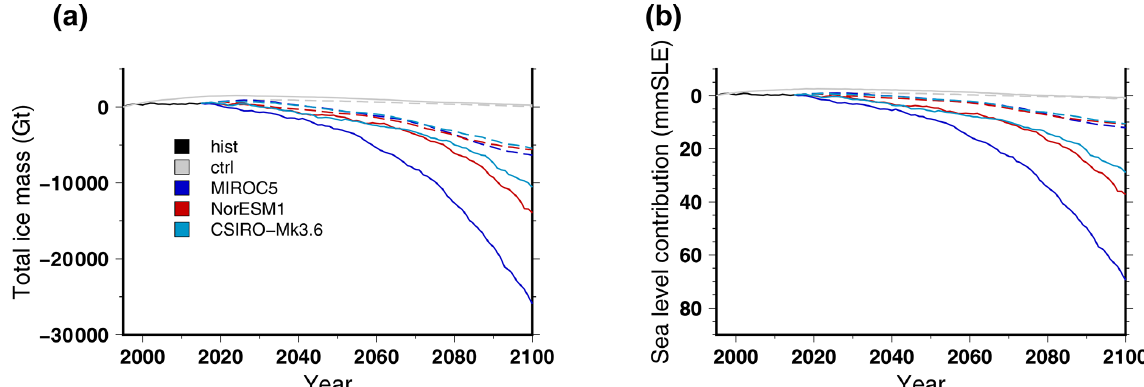
Figure 9. Simulated total ice mass change for the historical experiment hist (1995–2015), the control experiments ctrl (solid grey lines) and ctrl_proj (dashed grey lines) and the projections under different CMIP5 forcings using the RCP8.5 scenario. For the projections, the solid lines stand for experiments under atmospheric-forcing change only (no imposed outlet glacier retreat, AO) while the dashed lines stand for experiments under oceanic forcing change only (no change in surface mass balance, OO). The changes are expressed as (a) total mass change and (b) ice volume contributing to sea level rise. The medium oceanic sensitivity has been used for the oceanic only experiments (OO).